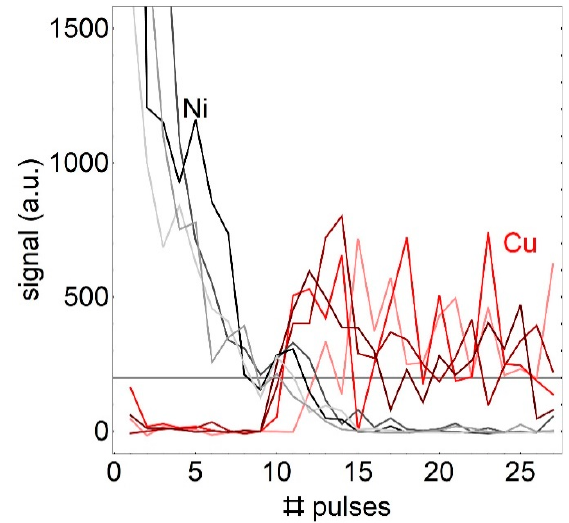
Figure 5. Intensity of Ni (grey tones) and Cu-lines (red tones) as a function of the laser pulses for a 25 µm thick nickel coating, ablated with 6 ns pulses. The 4 lines show a measurement at 4 different positions.